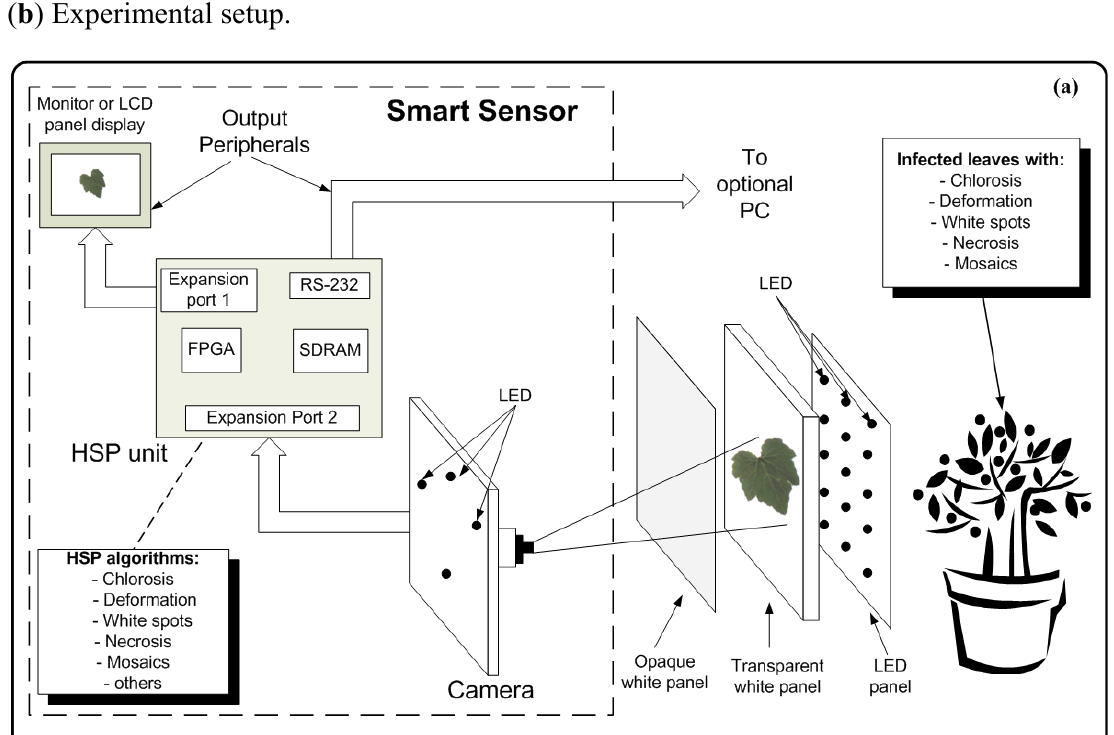
Figure 11. Smart-sensing methodology. ( a ) Block diagram of the proposed system. ( b ) Experimental